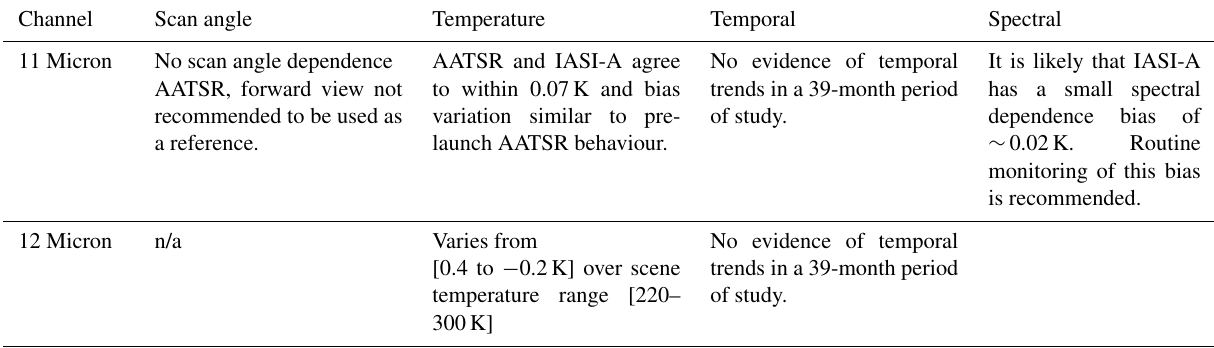
Table 3. Summary of AATSR vs. IASI-A inter-comparison. The table shows the measurements of the two instruments agree with each other. Channel Scan angle Temperature Temporal Spectral It is likely that IASI-A No evidence of temporal AATSR and IASI-A agree 11 Micron No scan angle dependence has a small spectral trends in a 39-month period to within 0.07K and bias AATSR, forward view not dependence bias of of study. variation similar to pre- recommended to be used as ∼ 0.02K. Routine launch AATSR behaviour. a reference. monitoring of this bias is recommended. No evidence of temporal 12 Micron n/a Varies from trends in a 39-month period [0.4 to − 0.2K] over scene of temperature range [220– 300K]